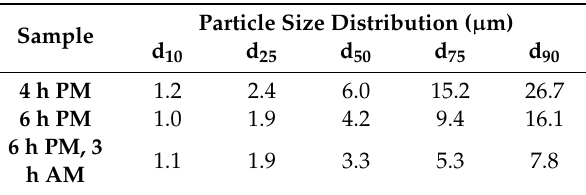
Table 3. Particle size distribution after di ff erent times of milling. PM, planetary milling; AM, attrition